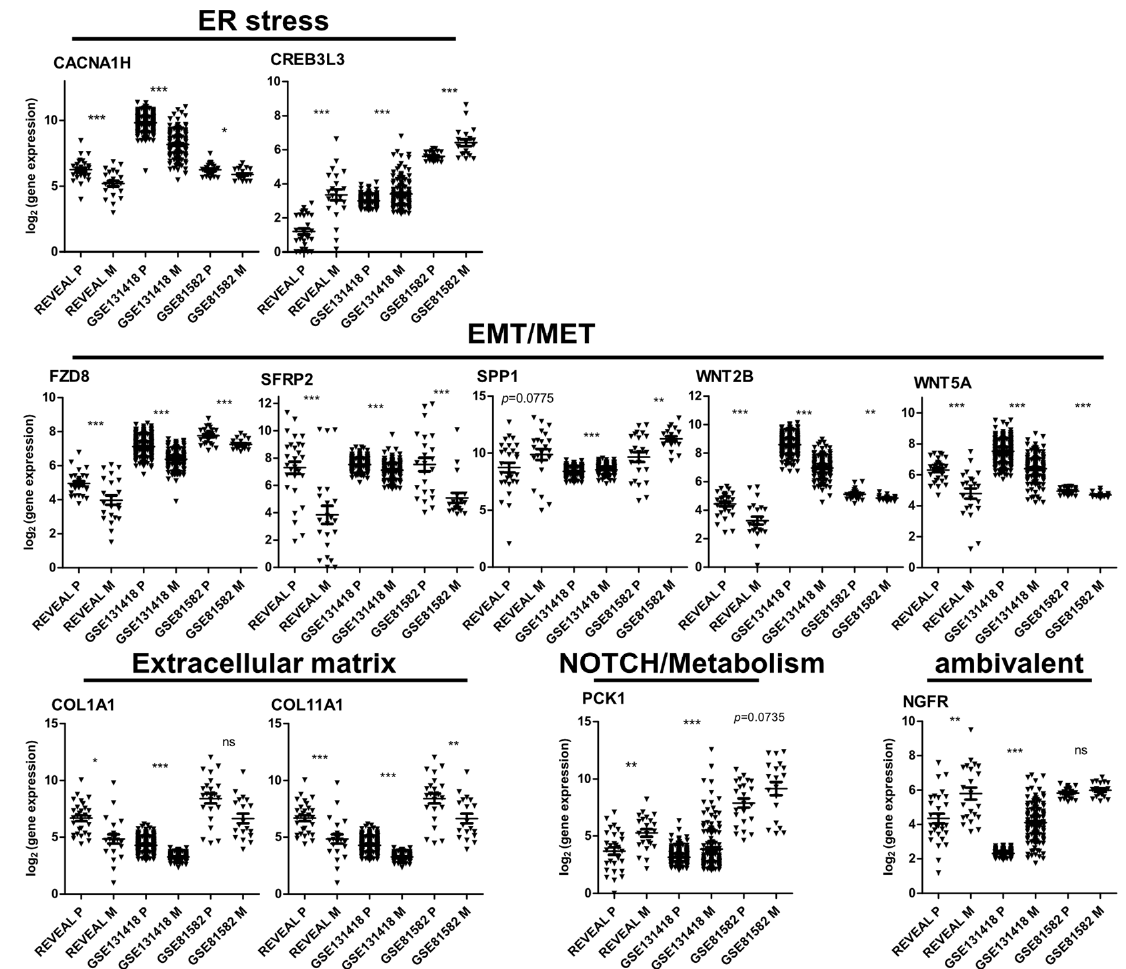
Figure 7. Expression of signature genes that showed the same significant trend (up/down regulation in M) in the REVEAL, GSE131418 and GSE81582 data sets. Associated cellular programs/pathways for each gene are indicated. Significance levels were calculated by moderated t -test with